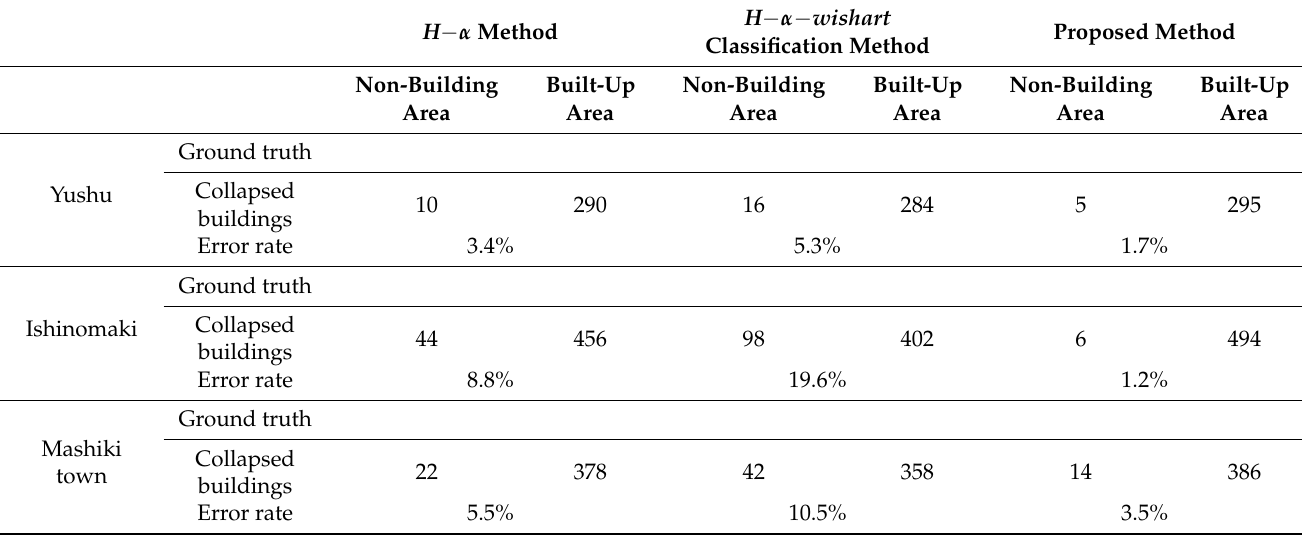
Table 5. Error rates of different methods in three study sites.